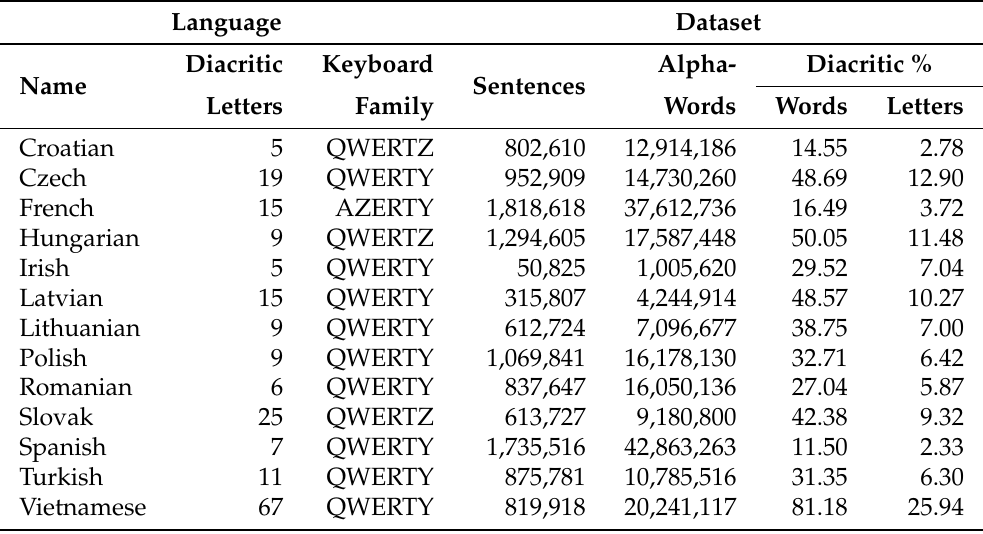
Table 1. Languages and the training dataset statistics. Diacritic percentages are calculated among alphabetical words or letters. Alphabetical words (alpha-words) range from 72% to 86% of all the total words, including